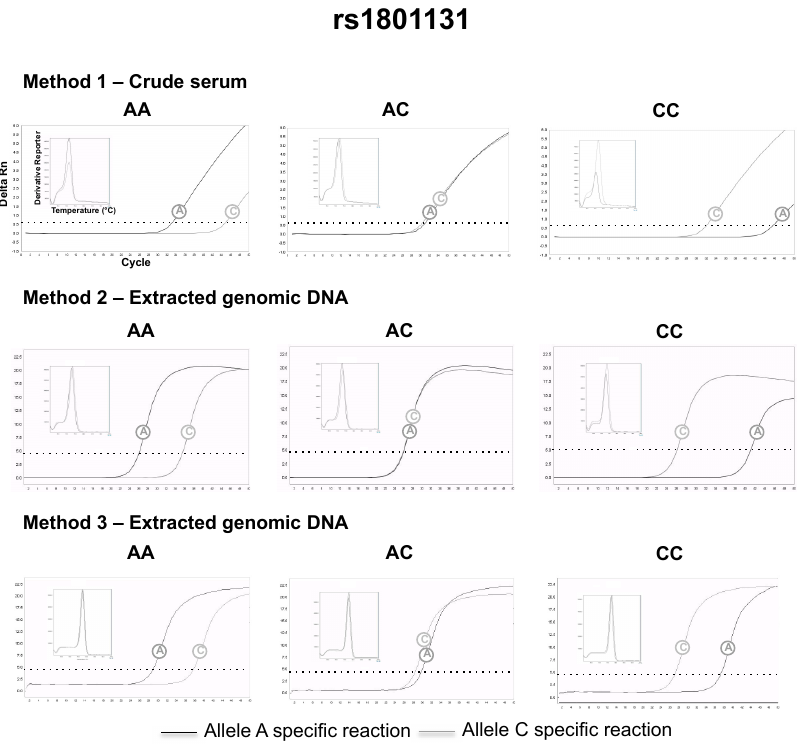
Figure 4. Representative rs1801131 genotyping using method 1 (2 μ L of crude serum separated 4 h after the capillary blood collection), 2 and 3.